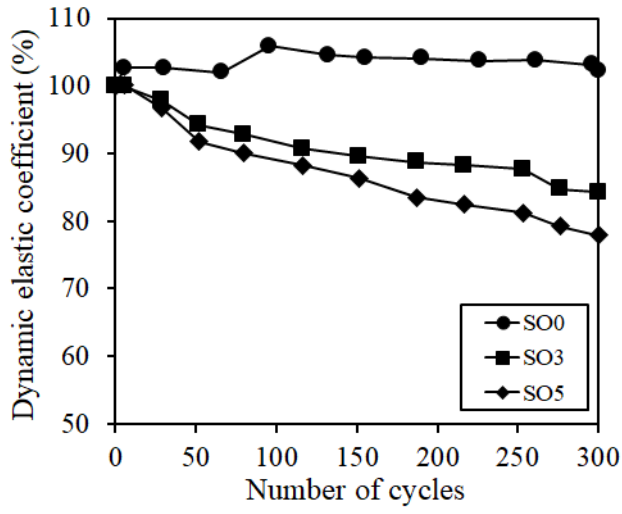
Figure 8. Dynamic elastic coefficient.